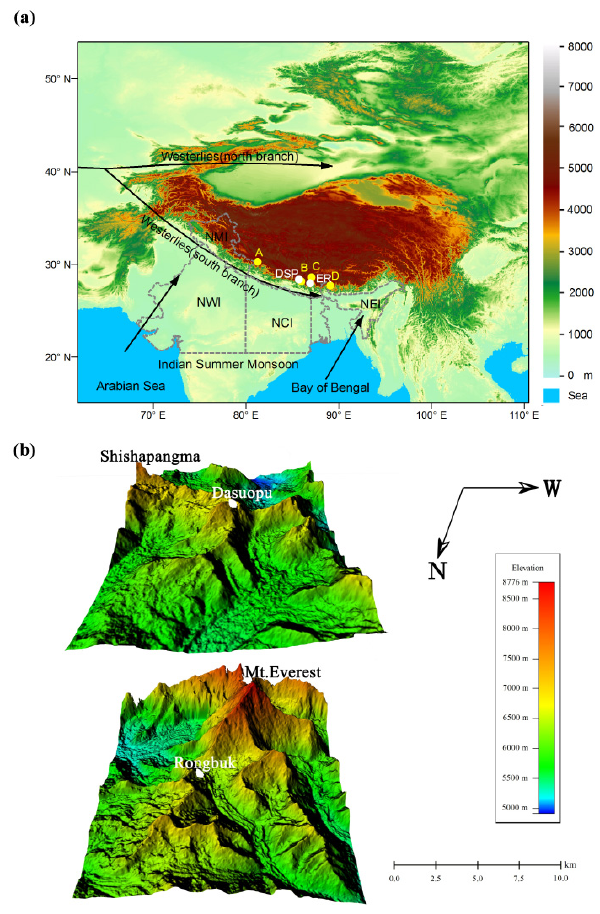
Fig. 1. Atmospheric circulation systems over the study area (a) , and three-dimensional topographic maps of the DSP and ER glaciers (b) . Filled yellow circles indicate weather stations (A: Pulan; B: Nyalam; C: Dingri; D: Pali), and the filled white circles are the DSP and ER ice core drilling sites. The grey dashed lines are bound- aries of the four Indian homogenous rainfall regions north of 21 ◦ N (i.e., NEI: northeastern India; NCI: north-central India; NWI: north- western India; NMI: northern mountainous India). Boundary lines are for reference only and may not denote actual political bor- ders. Digital elevation model (DEM) data are from ASTER (Ad- vanced Spaceborne Thermal Emission and Reflection Radiometer) global DEM version 2 with 30m resolution, which is available at